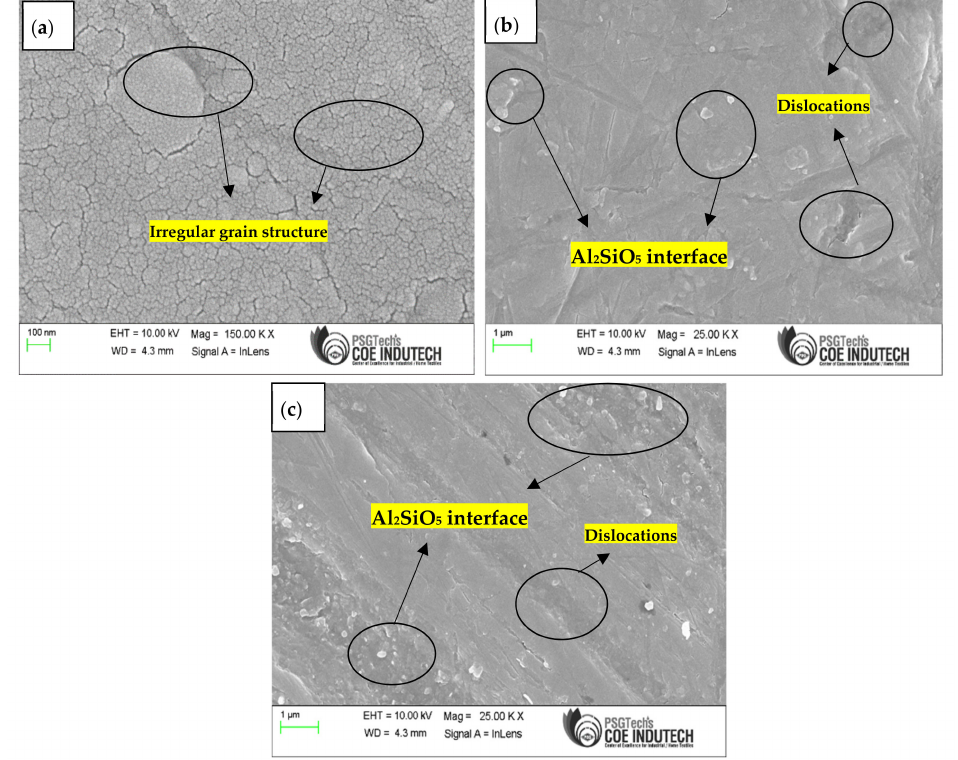
Figure 7. FE–SEM image of the as-cast: ( a ) AA5083; ( b ) 1% by weight of Al 2 SiO 5 -reinforced composite materials; ( c ) 2% by weight of Al 2 SiO 5 reinforced composite